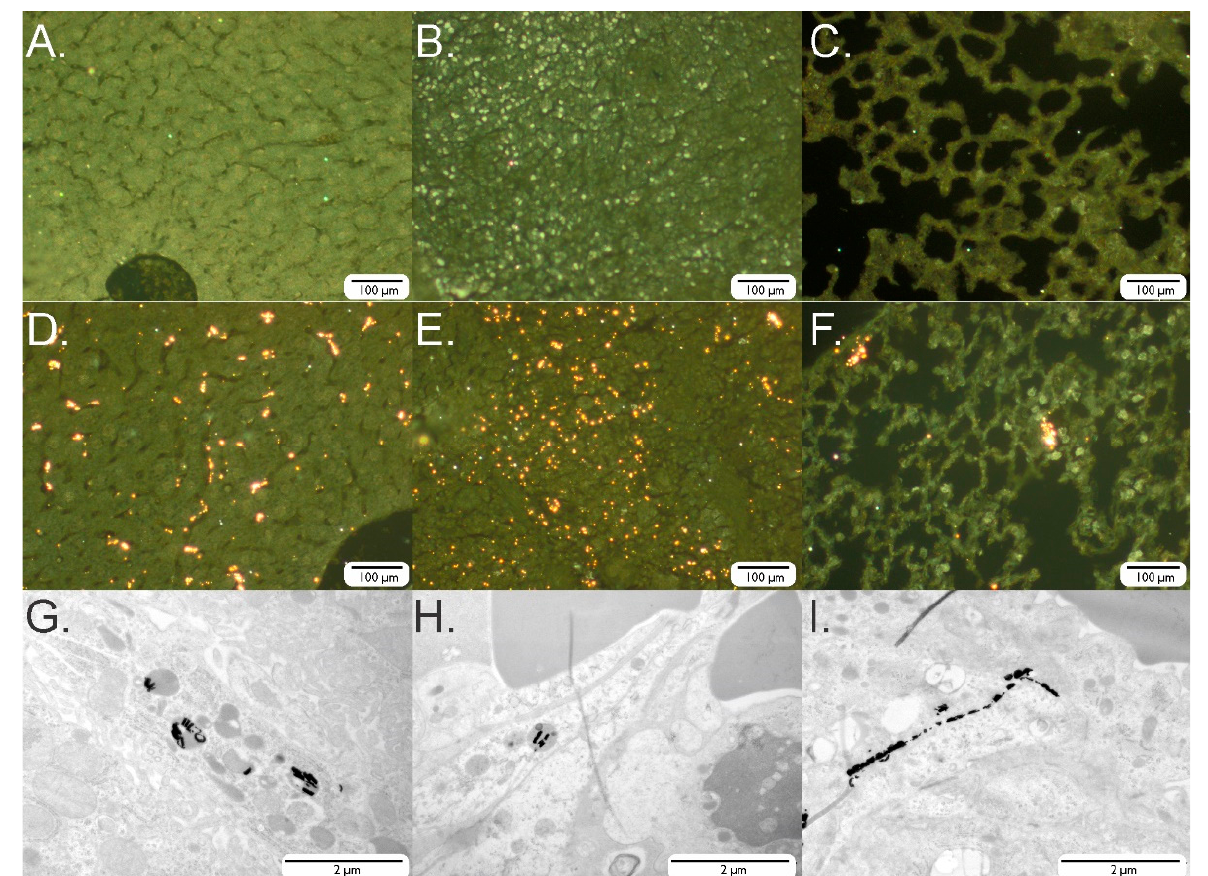
Figure 6. Ex vivo dark-field and TEM images of the liver, spleen and lung cells after injection of SAF-NPs and SAF-NP- labeled cells. ( A – C ) Dark-field images of slices of the liver ( A ), spleen ( B ) and lungs ( C ) of control mice. ( D , E ) Dark-field and ( G , H ) TEM images of a slice of liver ( D , G ) and spleen ( E , H ) after intravenous injection of SAF-NPs. ( F ) Dark-field and ( I ) TEM images of a lung slice after intravenous SAF-NP labeled cell injection.